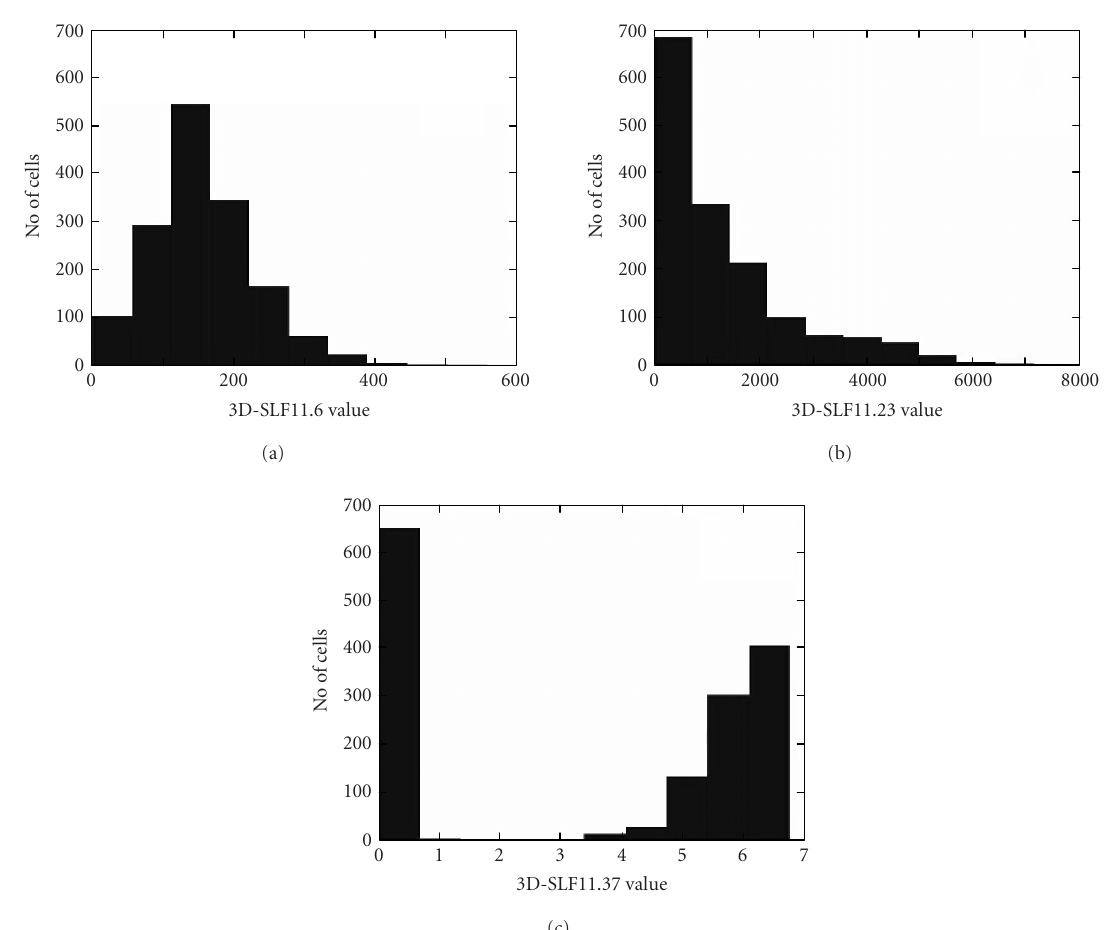
Figure 3. Histograms of selected features before z-score normalization. Examples of features with (a) a roughly Gaussian distribution (3D-SLF11.6, average object to center of fluorescence distance), (b) a roughly Poisson distribution (3D-SLF11.23, texture feature average of co-occurrence matrix sum variance), and (c) a biomodal distribution (3D-SLF11.37, texture feature range of co-occurrence matrix sum entropy).